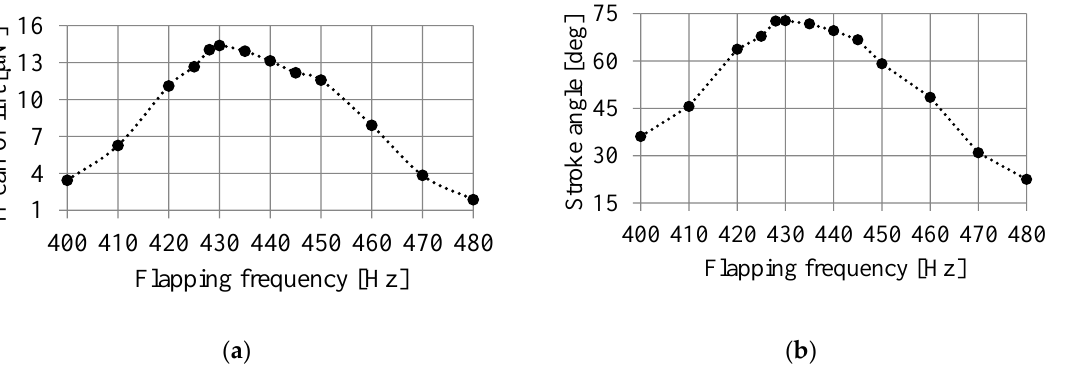
Figure 17. Frequency response functions of ( a ) the mean lift and ( b ) the stroke angle.